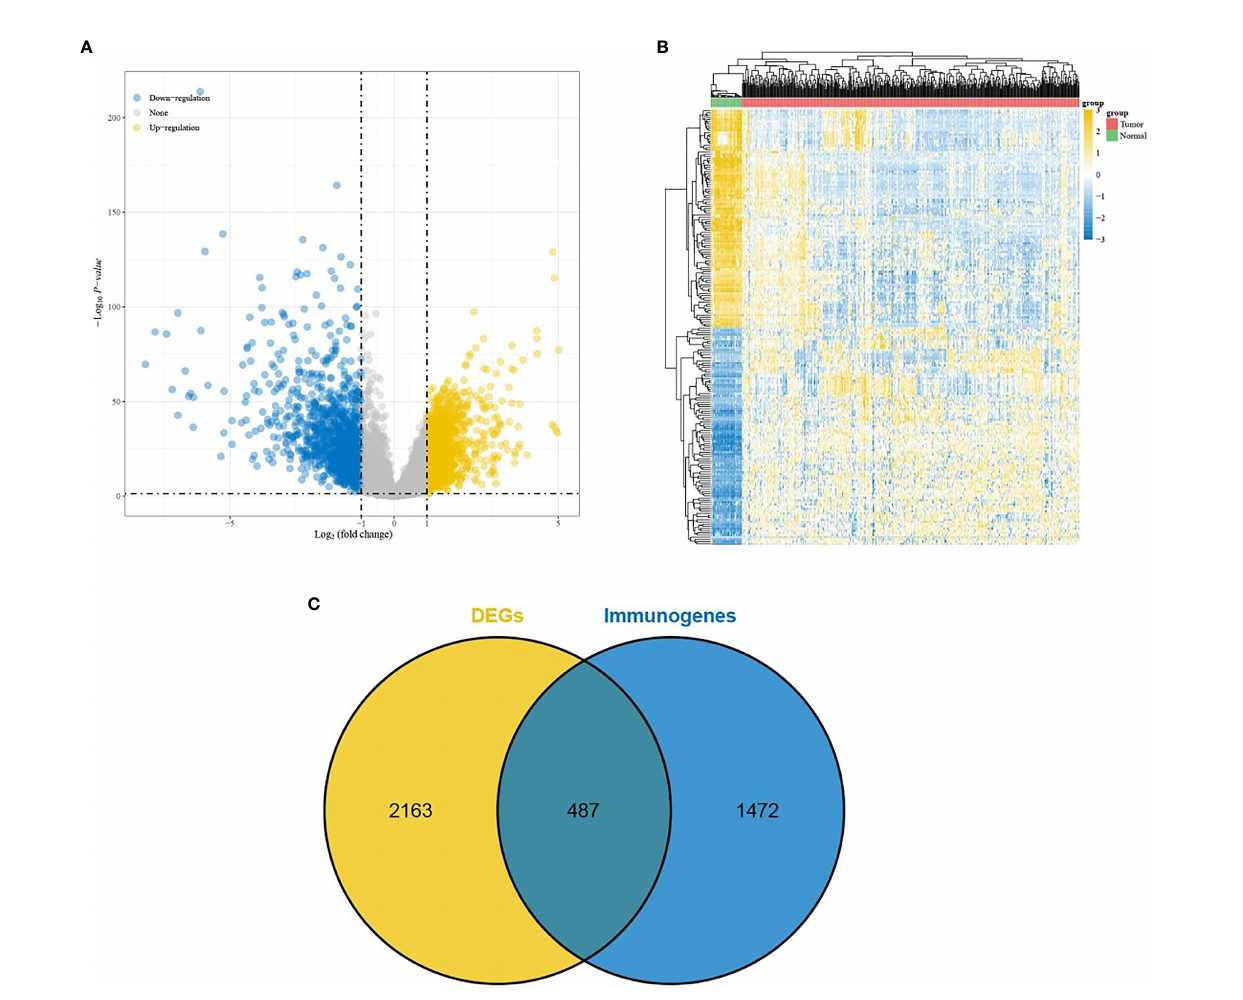
FIGURE 1 | Screening of DEGs. (A) Volcano plot and (B) Heat map comes from TCGA database; (C) Veen plot, taking the intersection of DEGs and immune- related